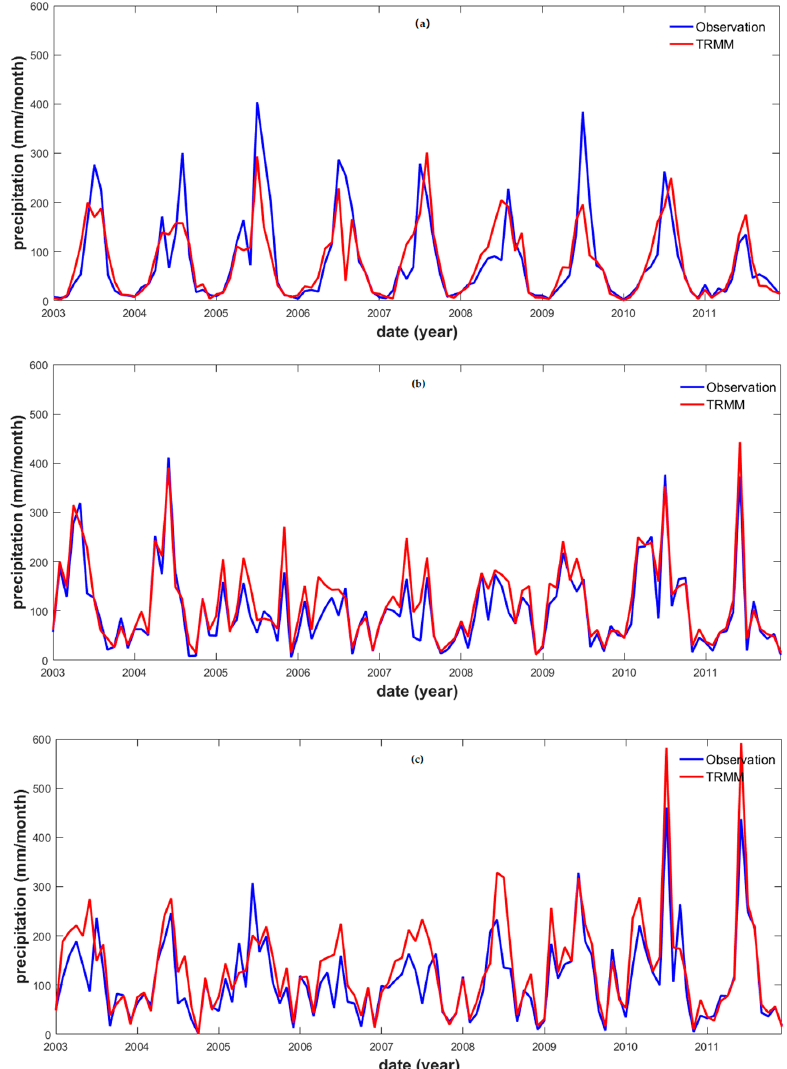
Figure 3. TRMM and observation precipitation time series in correspondence of the ( a ) Pingshan (upper reaches), ( b ) Chenglingji (middle reaches), and ( c ) Datong (lower reaches) stations. Table 2. Statistical comparison between the remotely sensed precipitation data and the observed precipitation data at the three selected stations, located along the upper, middle, and lower reaches of the Yangtze River basin.